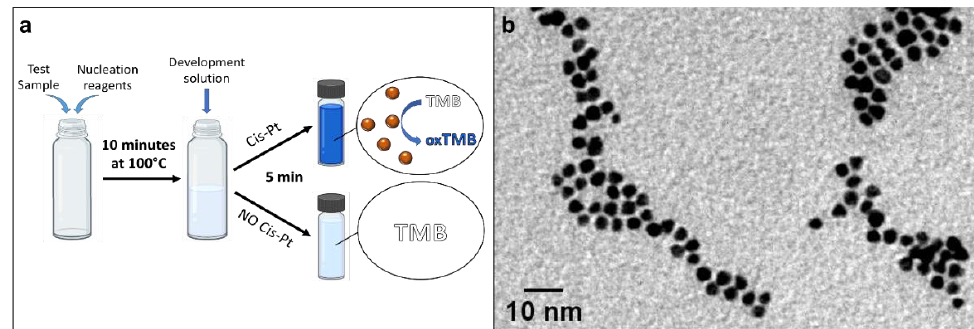
Figure 1. ( a ) Scheme of the two-step colorimetric method for the detection of cisplatin. In the pres- ence of the chemotherapeutic drug, the reducing agent quickly promotes the formation of small (ca. 4 nm diameter) monodisperse PtNPs, which in turn catalyze the oxidation of the TMB chromogen, with consequent formation of a visible blue color. In the absence of cisplatin contaminations, the solution remains transparent. ( b ) Representative TEM image of the PtNPs formed from cisplatin.